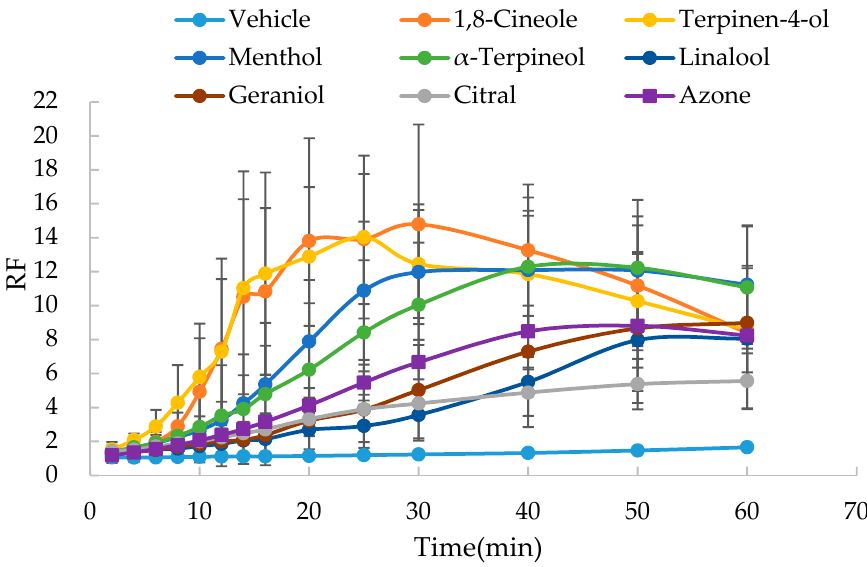
Figure 5. Effect of oxygen-containing terpenes dissolved in isopropanol-PBS (1:1) on the resistance reduction factor (RF) values of excised rat skin ( n = 5).